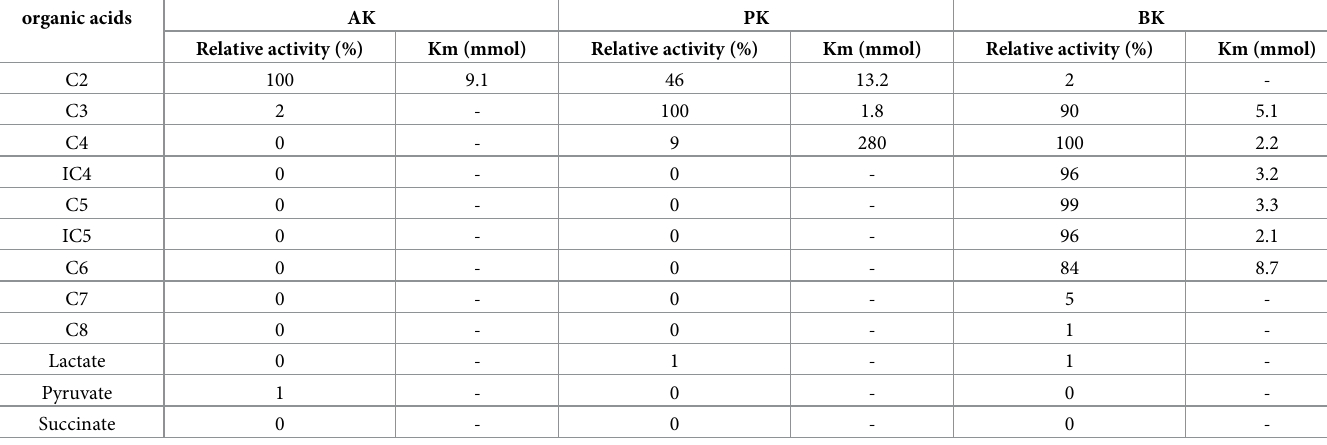
Table 3. Substrate specificity of AK, PK, and